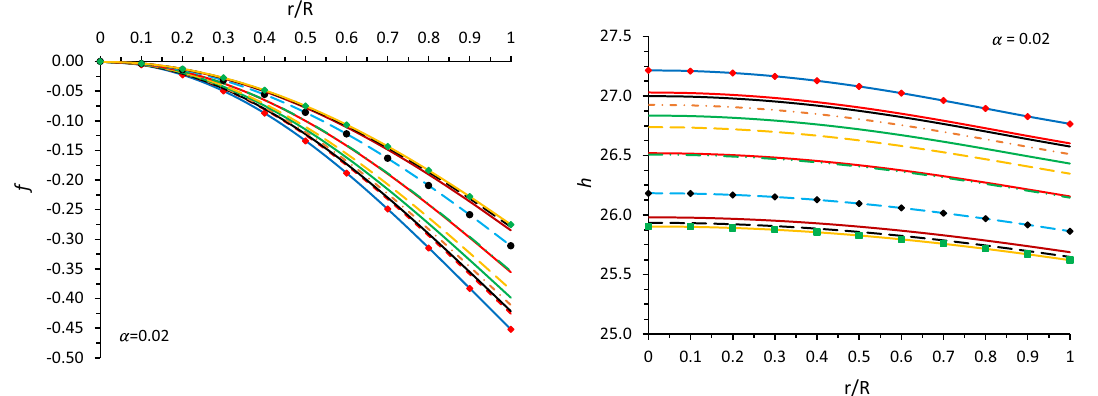
Fig. 3 The variations of deformation functions f ( r ) and h ( r ) versus radius r / R by taking the numerical values of the constants a = 0 . 003, b = 0 . 0000053, β = 1 . 1, and γ = − 0 . 001. The description of the curves are given at the footnote